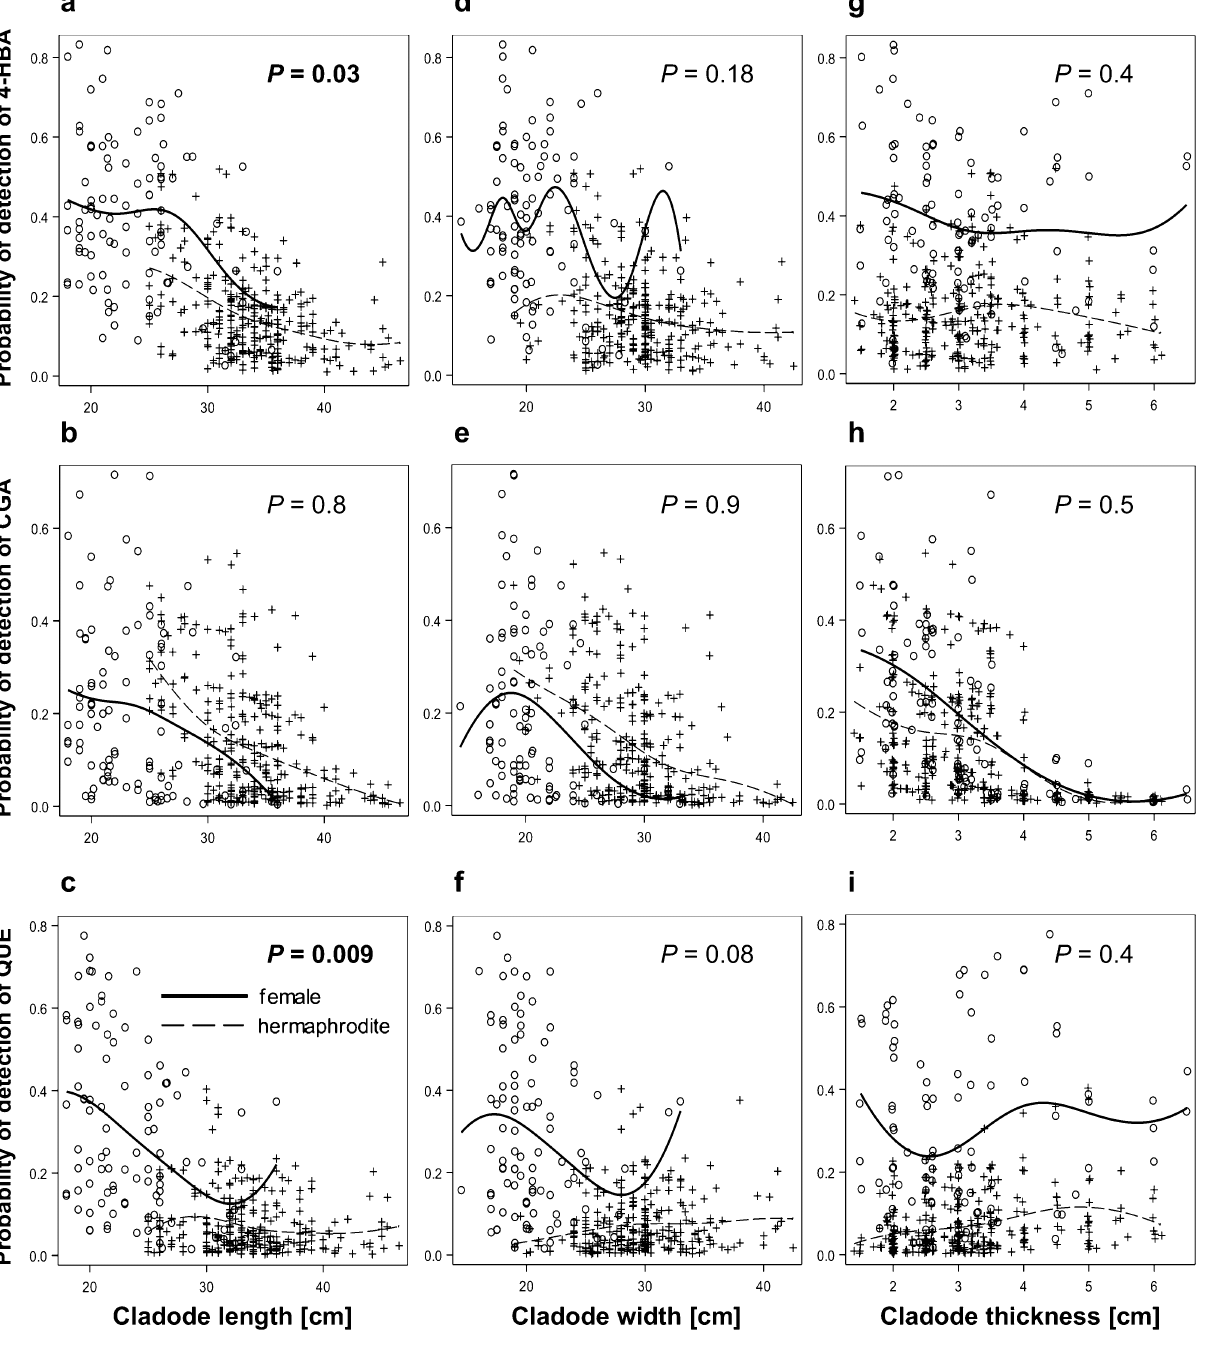
Figure 7. Effects of cladode length ( a , b , c ), width ( d , e , f ), and thickness ( g , h , i ) on the detection probability of 4-hydroxybenzoic acid (4-HBA), chlorogenic acid (CGA), and quercetin (QUE) in the vegetative tissues of female and hermaphrodite cladodes. 4-HBA and QUE had higher detection probabilities in the shorter cladodes. Female cladodes had a higher detection probability for 4-HBA and QUE than hermaphrodite cladodes of the same length. There was no intersexual difference in the detectability of CGA. P— probability of the adjustment in the logistic regression model for pooled sexual forms. Significant relationships at P ≤ 0.5 are marked with bold